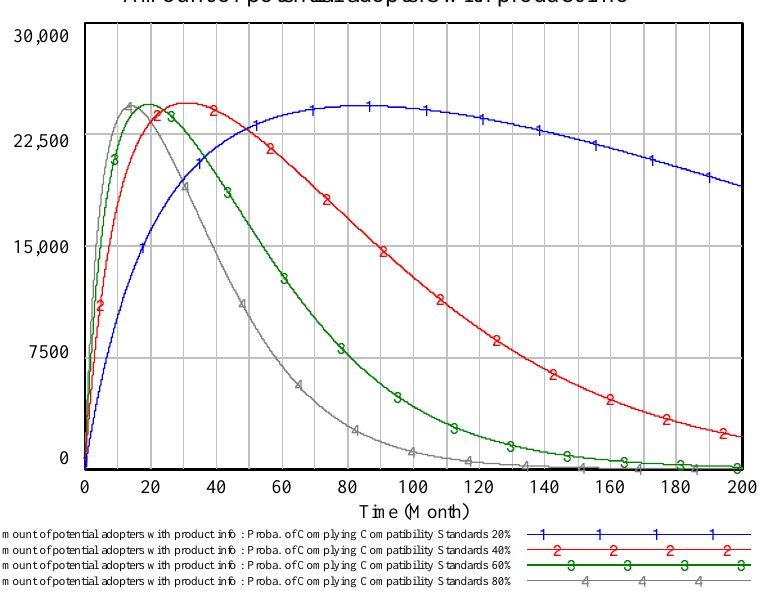
Figure 12. Sensitivity of probability of complying with compatibility standards on number of potential adopters with product info.